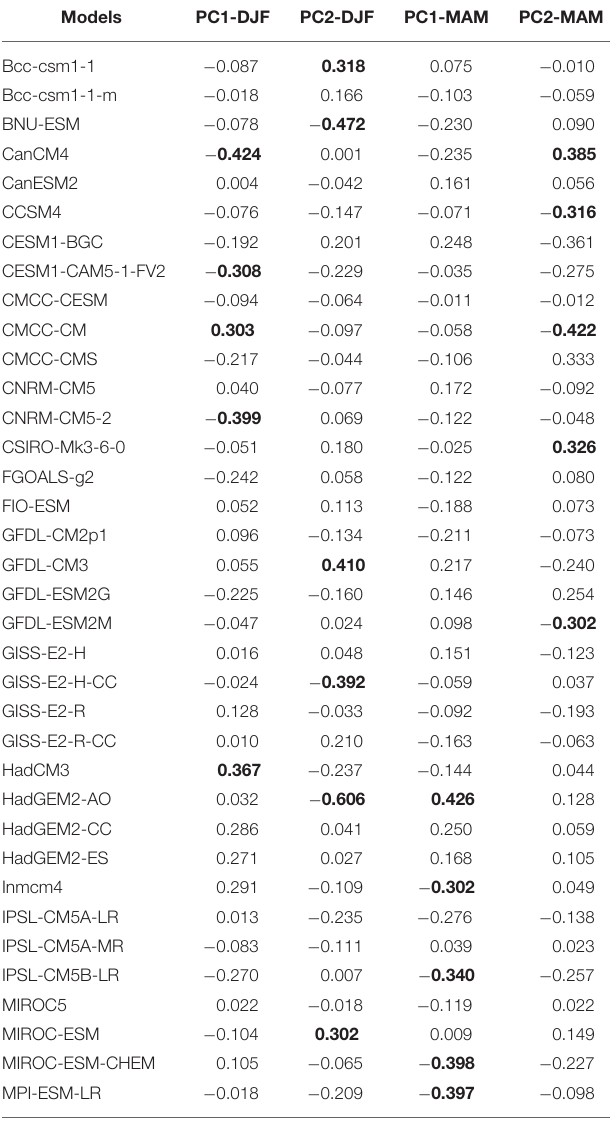
TABLE 6 | Same as Table 5, except for CMIP5 models. Models